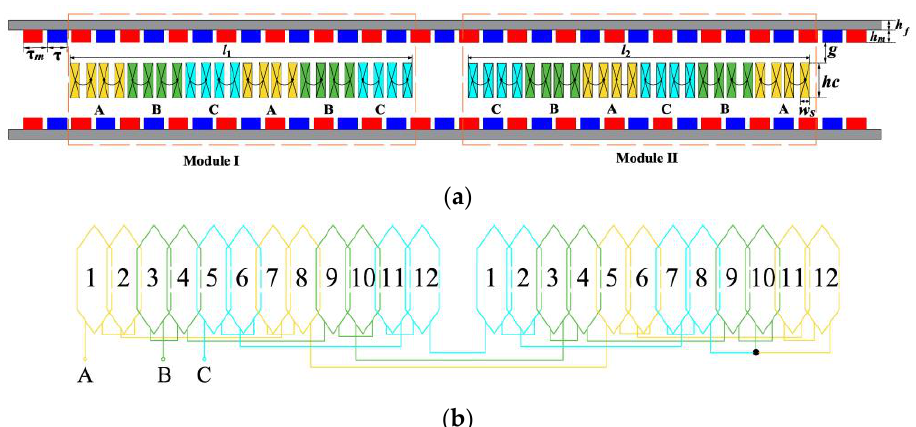
Figure 1. Three-dimensional view of the two-module PMLSM.